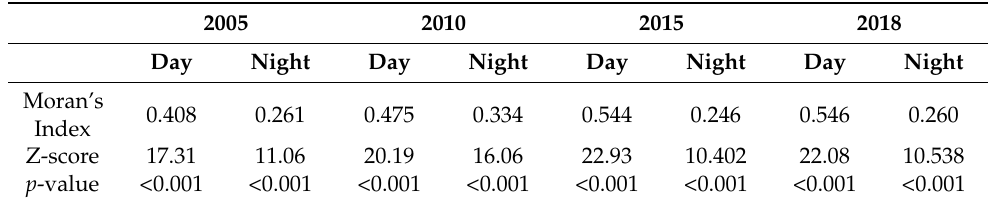
Table 3. Spatial autocorrelation statistics results for the SUHI intensity in each of the four time